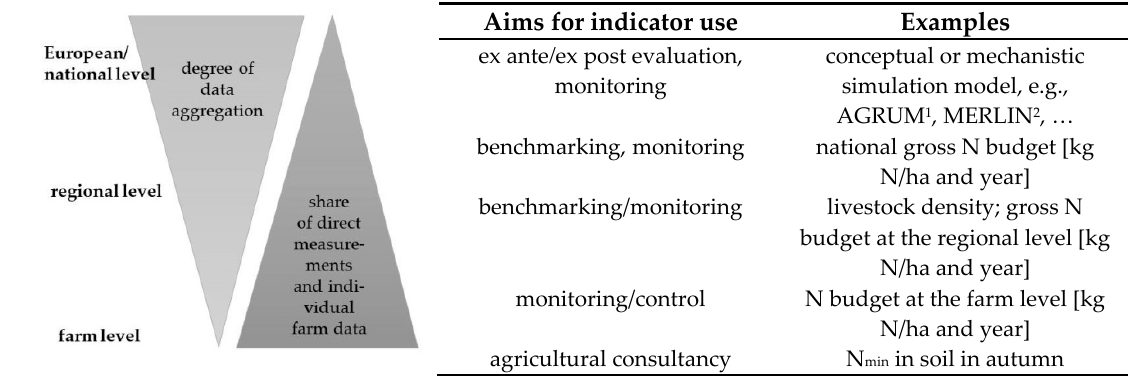
Figure 3. Degree of aggregation and individualization in relation to the operational level of agri-environmental indicators (with selected examples related to N assessment); Source : [29], with modifications. 1 Agricultural and Environmental Measures for Agricultural Water Protection [30], 2 Méthode de hiErarchisation du Risque de LIxiviation du Nitrate [31].